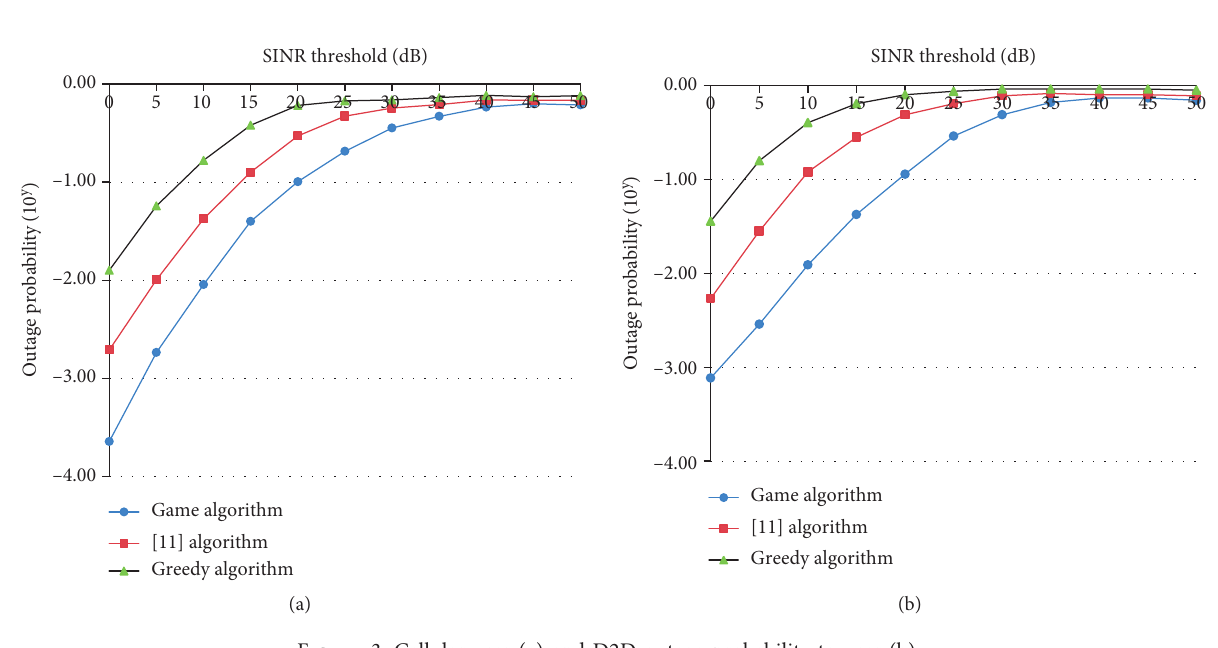
Figure 3: Cellular user (a) and D2D outage probability to user (b).